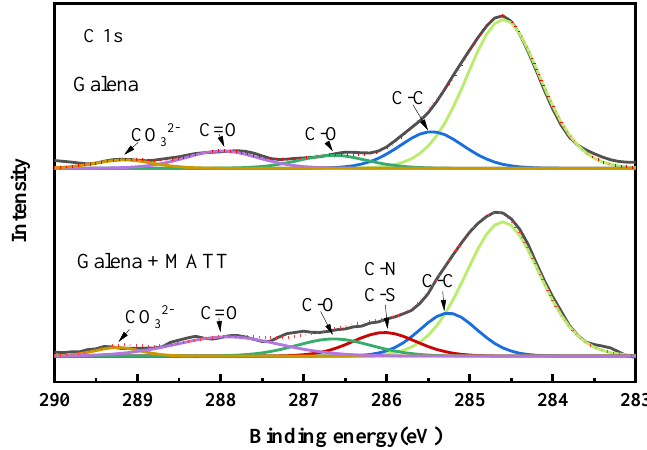
Figure 9. C 1s spectra of galena, galena treated with MATT.